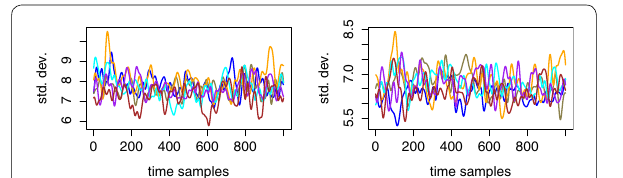
Fig. 5 Exemplary eigenvectors for the average PCA, corresponding to User 8, Electrode P7. Left: first dimension. Right: fifth